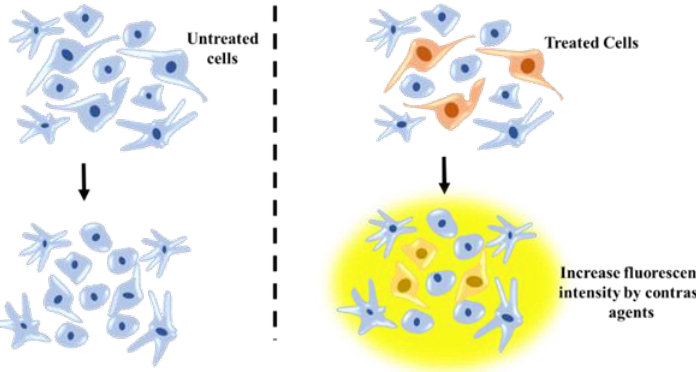
Figure 7. MRI technique for tracking posttransplanted neural stem cells (NSCs) using contrast agents and understanding NSC differentiation process.